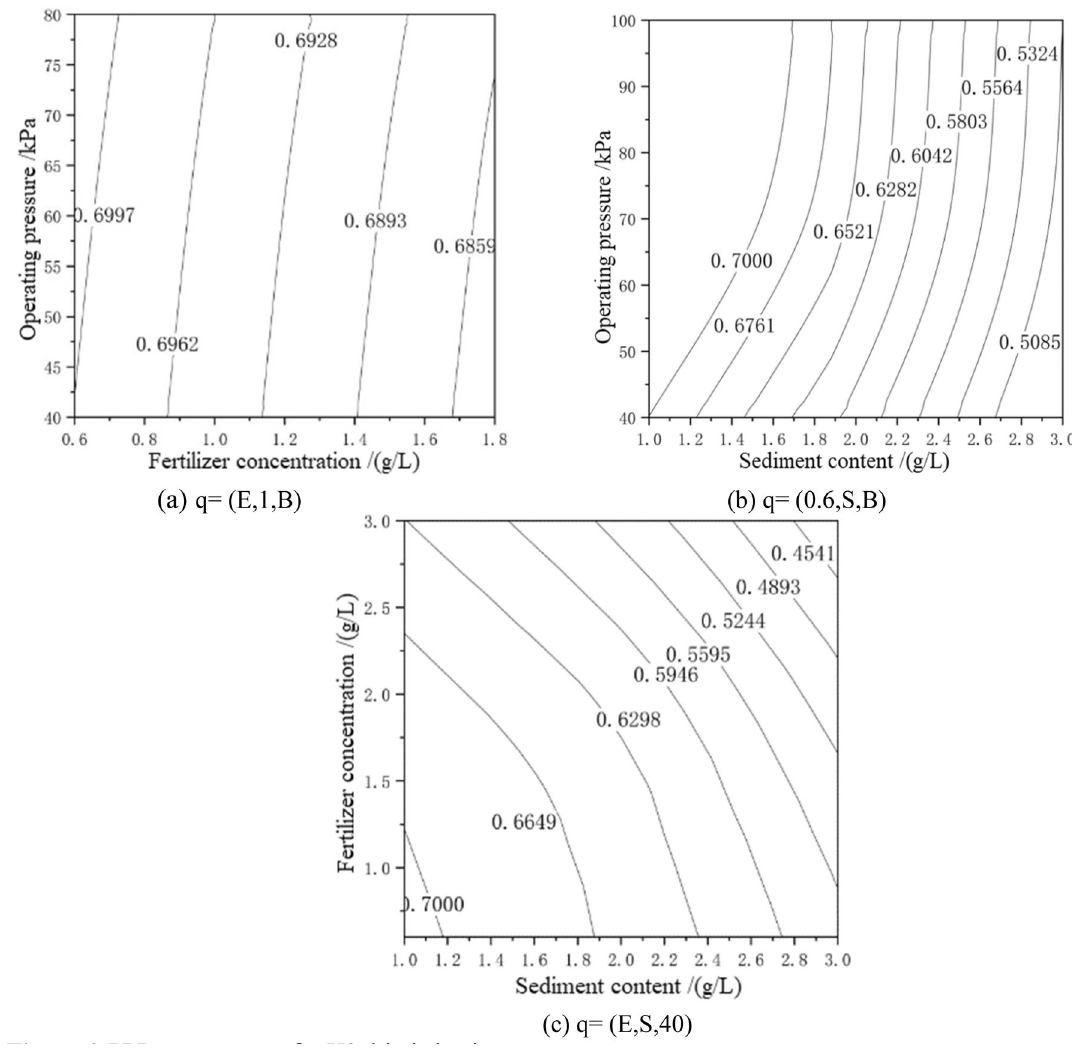
Figure 6. PPR contour map for H3 drip irrigation tape.